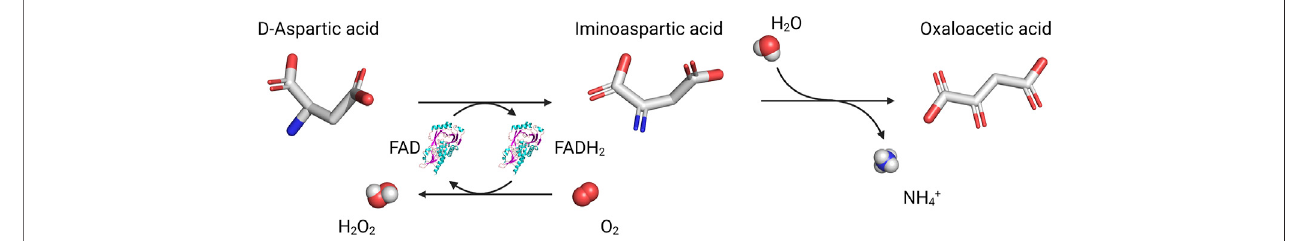
FIGURE 2 | Reaction catalyzed by DASPO on acidic D -amino